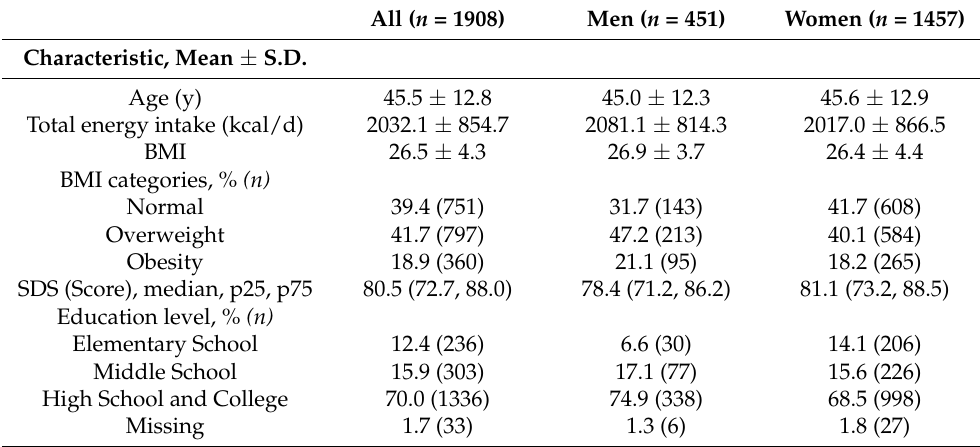
Table 2. Demographic characteristics of subjects from HWCS by gender 2004–2006. All ( n = 1908) Men ( n = 451) Women ( n = 1457) Characteristic, Mean ±